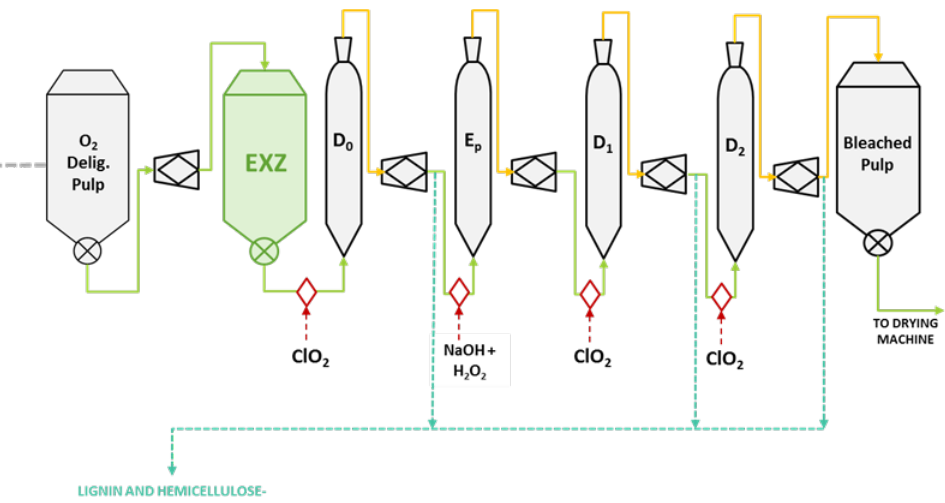
Figure 1. Scheme of the typical production process of a bleached kraft pulp (grey) with enzymatic treatment, EXZ stage (green), applied after the O 2 delignification stage.